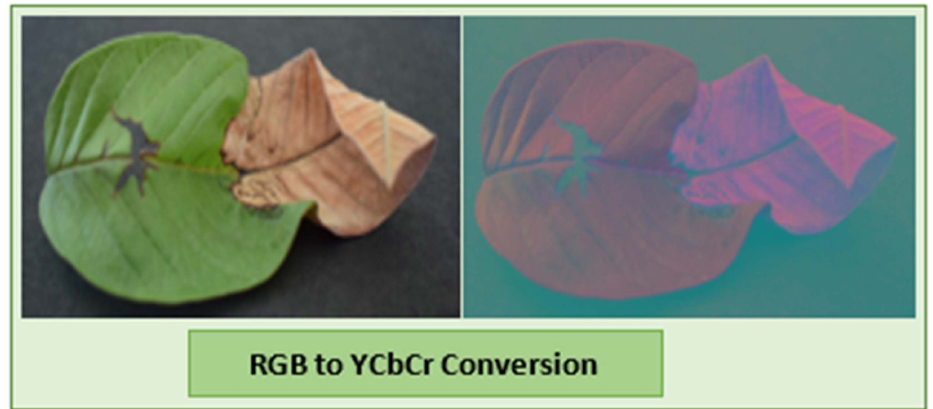
Figure 2. RGB to YCbCr